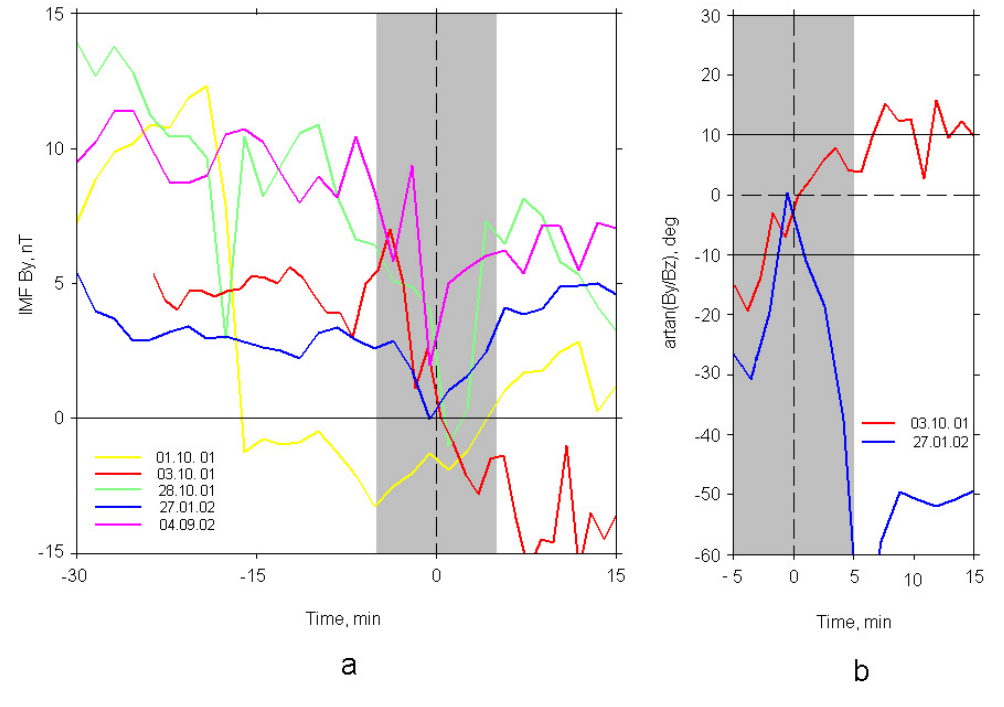
Fig. 9. ( a ) The results of superimposed epoch analysis for 5 events of the IMF B y component prior to the Pc1 enhancement. The shaded area is ± 5min from event onset. ( b ) The variation of the clock angle between the IMF B y and B z components for two Pc1